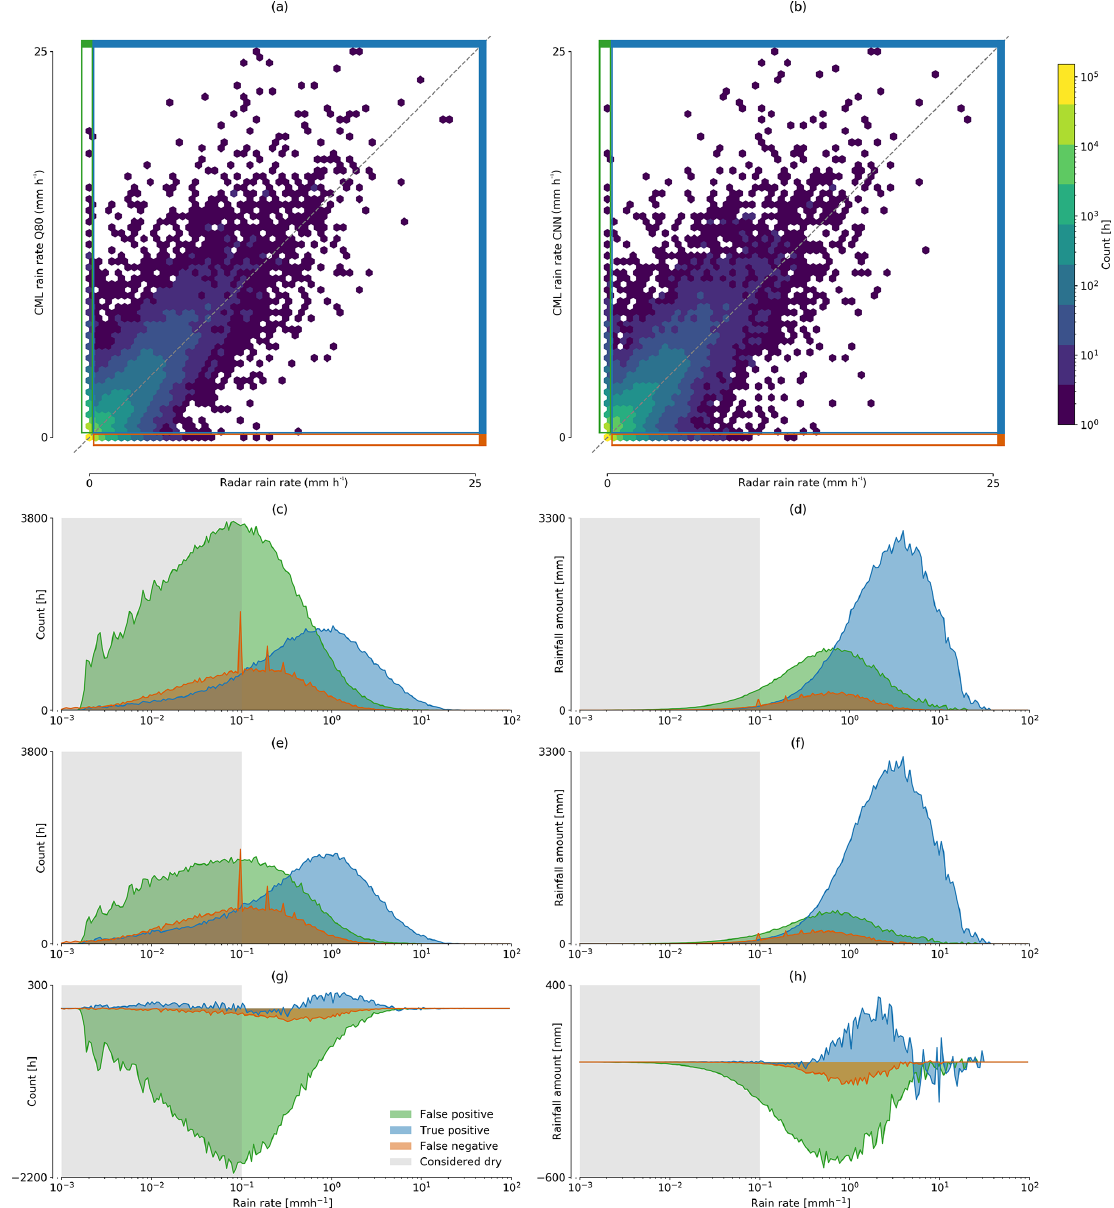
Figure 9. Scatter density comparison between hourly CML and radar rain rate estimates derived from (a) σ q80 and (b) the CNN. On the left-hand side the amount of FP, TP, and FN hours with a specific rain rate are compared for (c) σ q80 , (e) the CNN, and (g) their difference. On the right-hand side the amounts of rainfall these hours contribute are shown for (d) σ q80 , (f) the CNN, and (h) their difference. The rain rates for false positives and true positives are estimated by the CML, while the rain rates for false negatives are taken from the